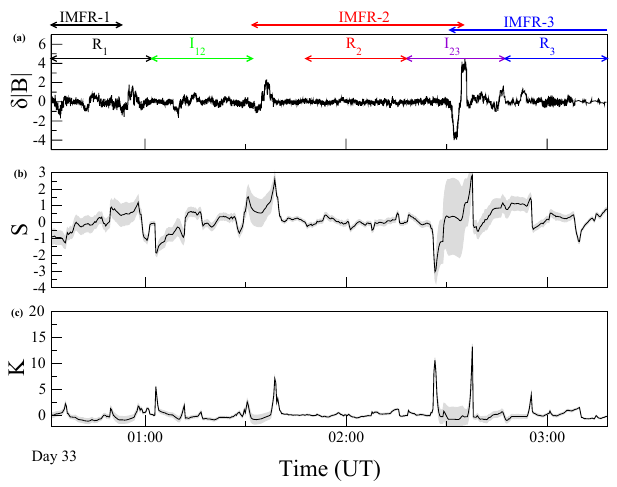
Figure 6. (a) Time series of δ B (τ = 100s ) from 00:00 to 04:00UT on 2 February 2002. Five regions of 30min each are highlighted us- ing different colors: interior of IMFR-1 ( R 1 , black), interface region of IMFR-1 and IMFR-2 ( I 12 , green), the interior of IMFR-2 ( R 2 , red), the interface of IMFR-2 and IMFR-3 ( I 23 , violet), and the in- terior of IMFR-3 ( R 3 , blue). The interval of each IMFR is indicated by horizontal arrows as in Fig. 1. (b, c) Time series of the skewness S and the kurtosis K computed using a sliding overlapping window with the same parameters as in Fig. 2. The SD computed in each window is represented by a gray area. Table 5. Same as in Table 3 for τ = 10s. The fitting function of IMFR-2 was not applicable (n/a) due to the small correlation value.